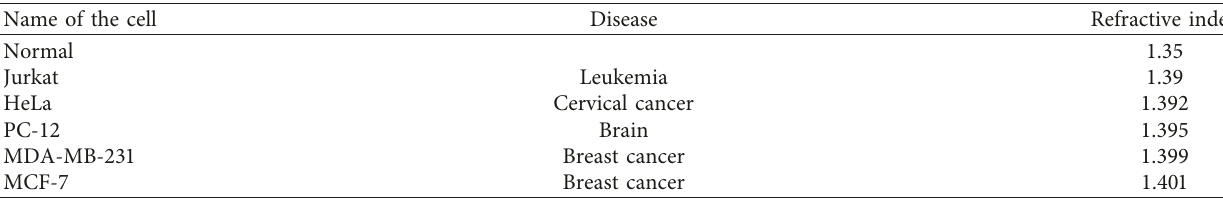
Figure 3: Novel gradient step rib-slot waveguide with analyte. Table 1: Refractive index of different cancer cells [32].